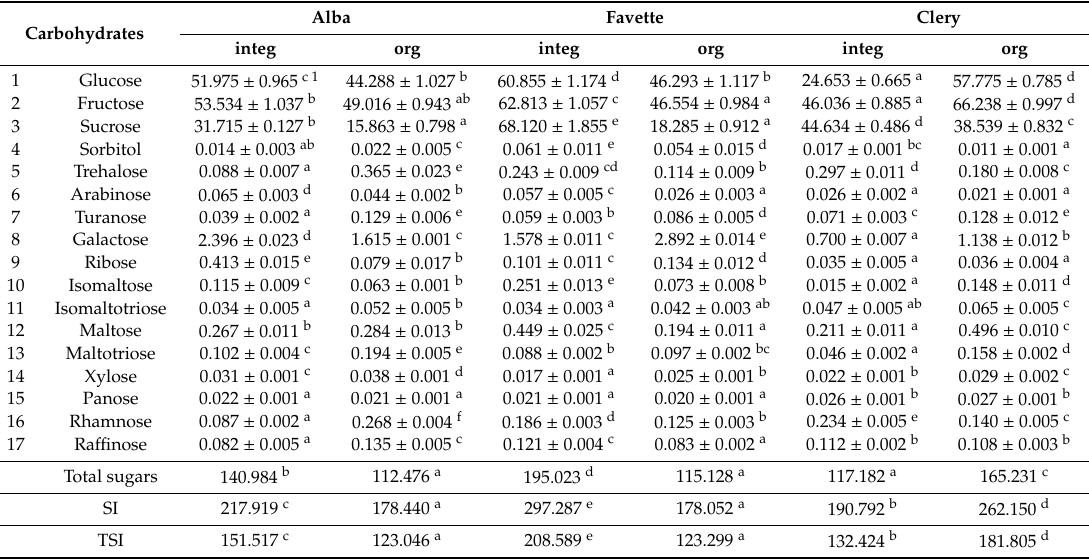
Table 1. Average contents of carbohydrates (mg / g), sweetness index (SI) and total sweetness index (TSI) in integrated (integ) and organic (org) strawberry fruits from three replications.